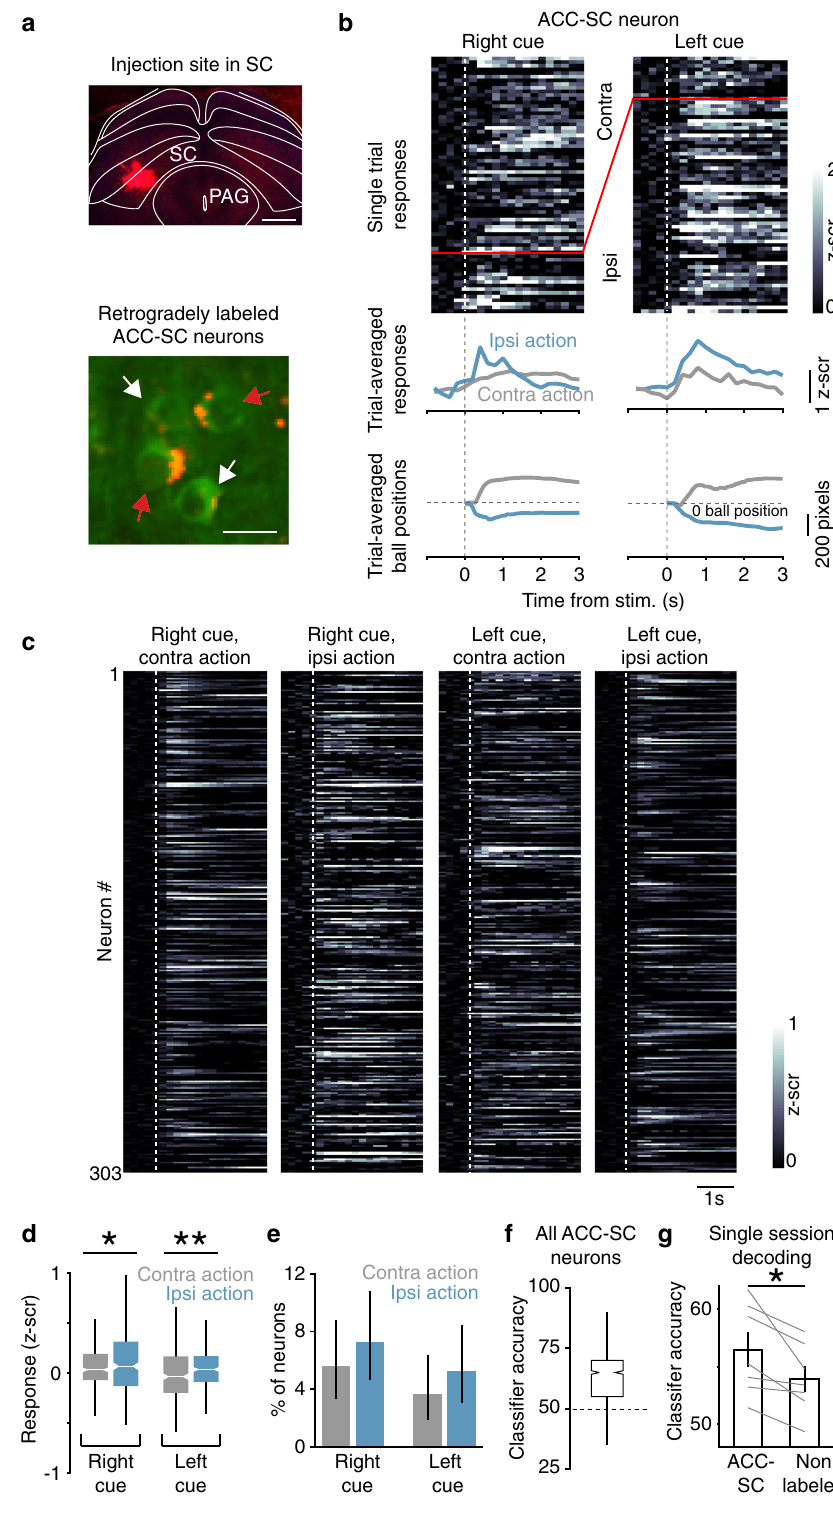
virally expressing Jaws in the ACC and implanting an optic fi ber cannula over the left SC to target ACC-SC inputs for inactivation (Fig. 4c). ACC-SC inactivation increased incorrect responses on left cue trials and there was a trend for decreased incorrect responses on right cue trials (Fig. 4d). That is, inactivation of left ACC-SC inputs decreased ipsiversive and increased contraversive actions, opposite to that observed with SC inactivation (Fig.